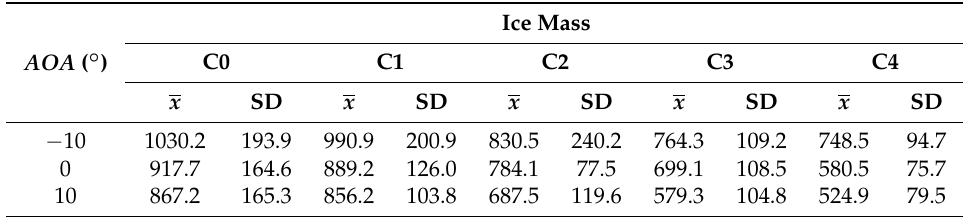
Table 4. The ice mass of C0–C5 under Conditions 3, 6, and 7.